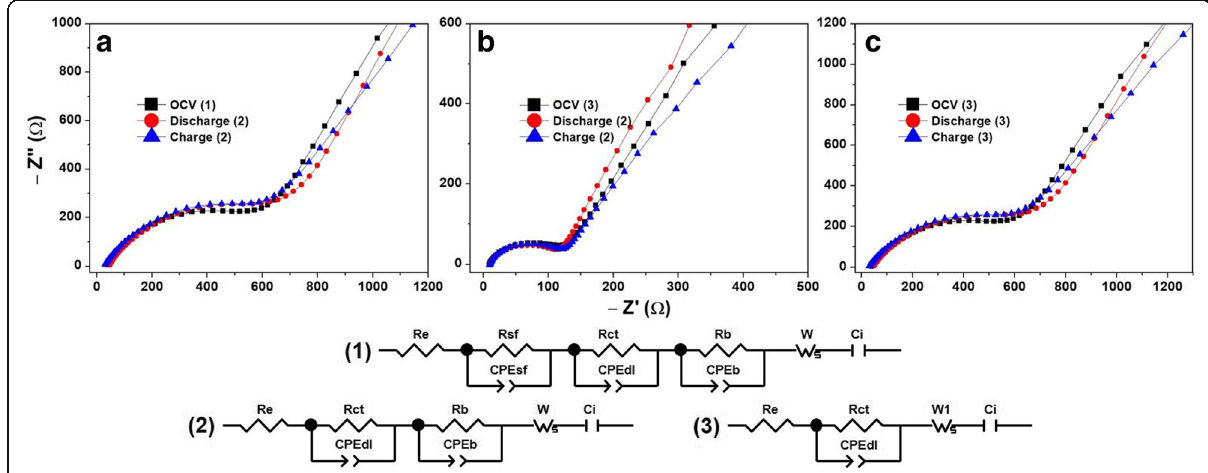
Fig. 10 Na-ion battery impedance analysis of a-VOx films deposited at pO2 ( a ) 6 Pa, ( b ) 13 Pa and ( c ) 30 Pa